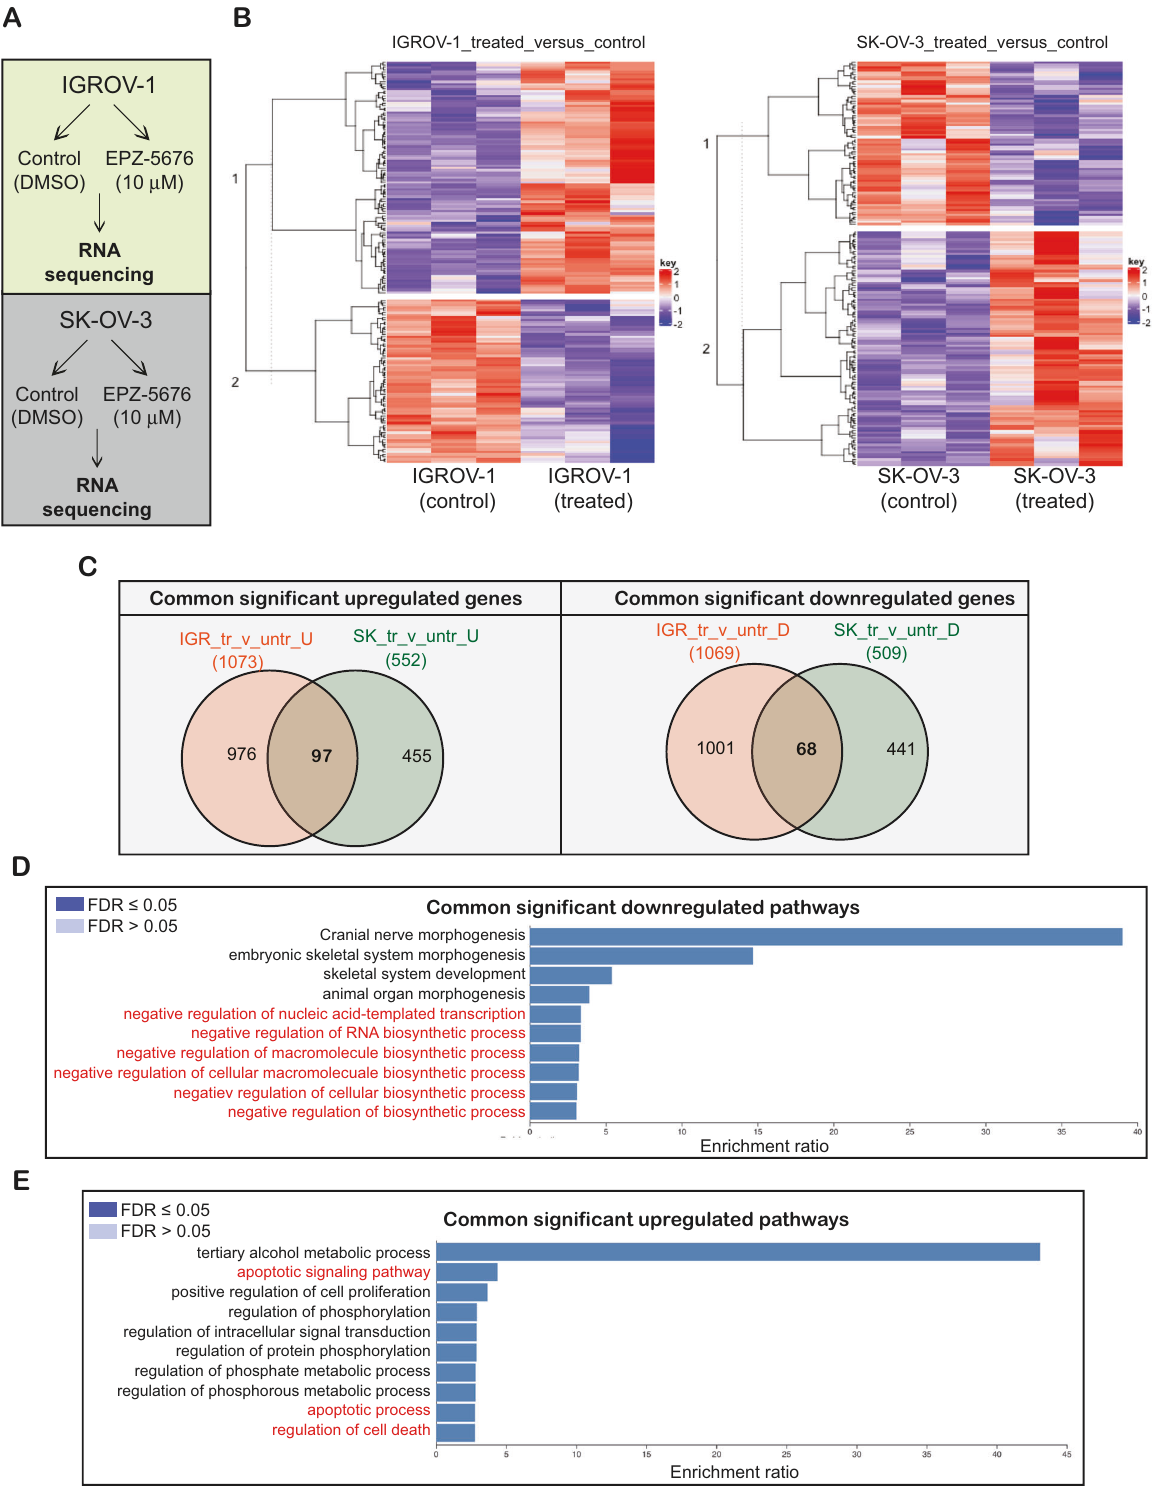
Fig. 4 Pharmacological inhibition of DOT1L leads to the alteration of multiple genes that affect the growth of ovarian cancer cells. A Schematics of the RNA sequencing analysis performed with IGROV-1 and SK-OV-3 cells. B Heatmaps show the overall alterations of gene expression in IGROV-1 and SK-OV-3 cells treated with 10 μ M EPZ-5676 for 48 h in comparison with control cells. C Venn diagrams show the genes that were signi fi cantly upregulated ( n = 97) or downregulated ( n = 68) in both cell lines (IGROV-1 and SK-OV-3) after treatment with 10 μ M EPZ-5676 for 48 h. D A bar diagram shows the pathways that were downregulated in both ovarian cancer cell lines after treatment with 10 μ M EPZ-5676 for 48 h. E A bar diagram shows the pathways that were upregulated in both ovarian cancer cell lines after treatment with 10 μ M EPZ-5676 for 48